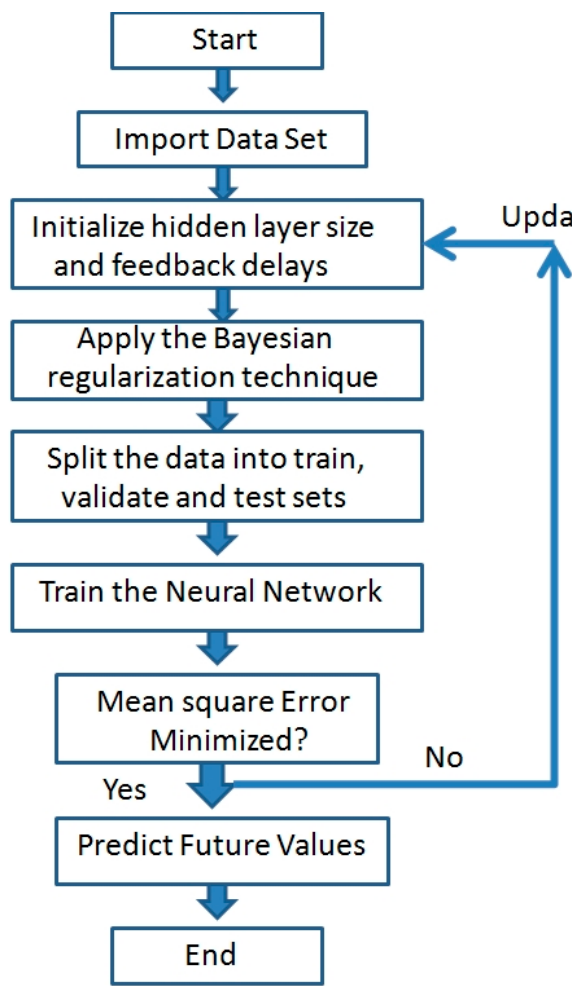
Figure 9. Flow chart for the implementation of neural network.